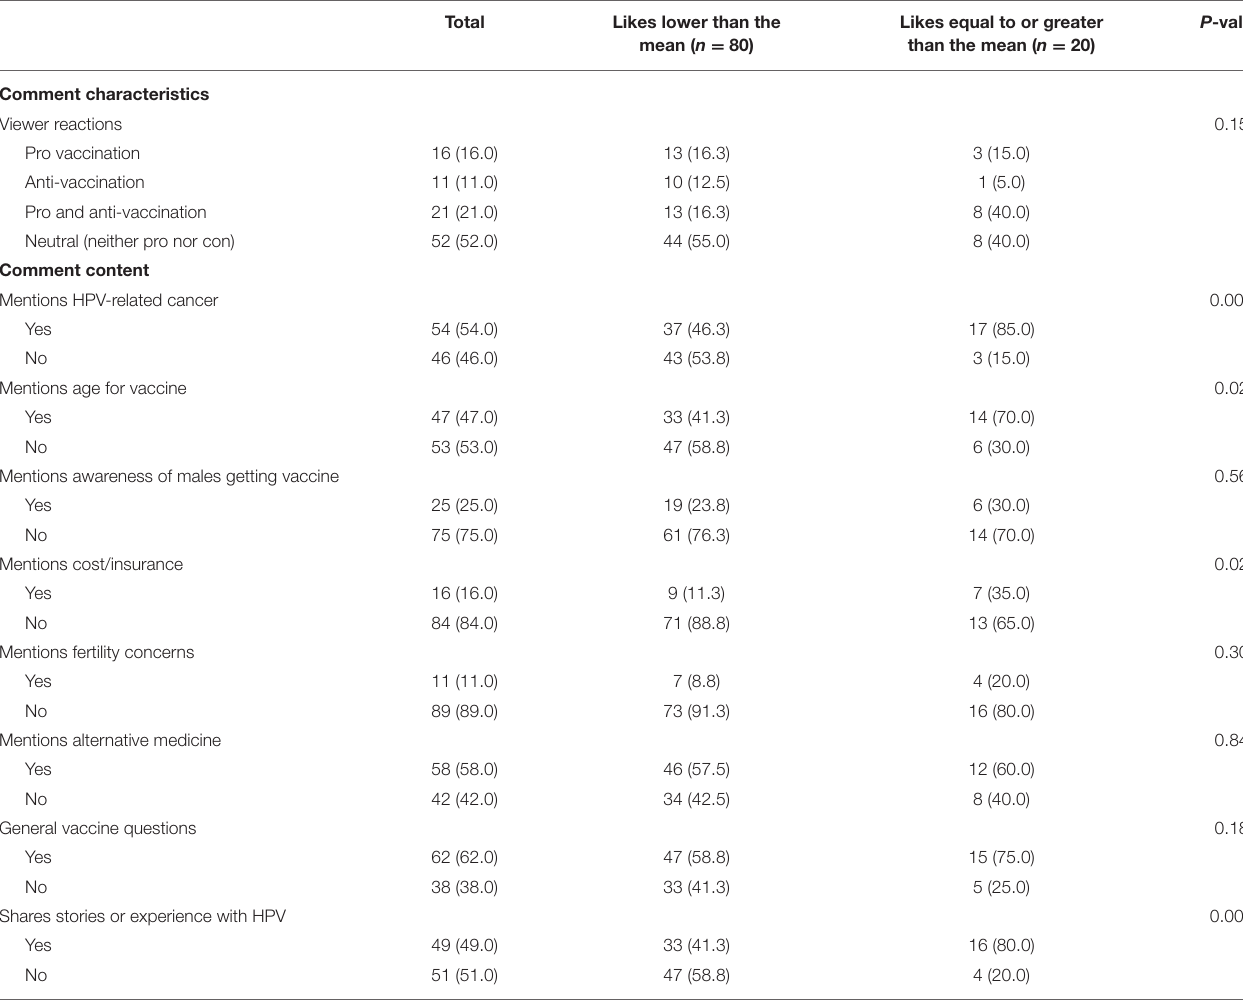
TABLE 2 | Comments about TikTok video related to HPV vaccination ( n = 100) by number of “likes”, dichotomized at the